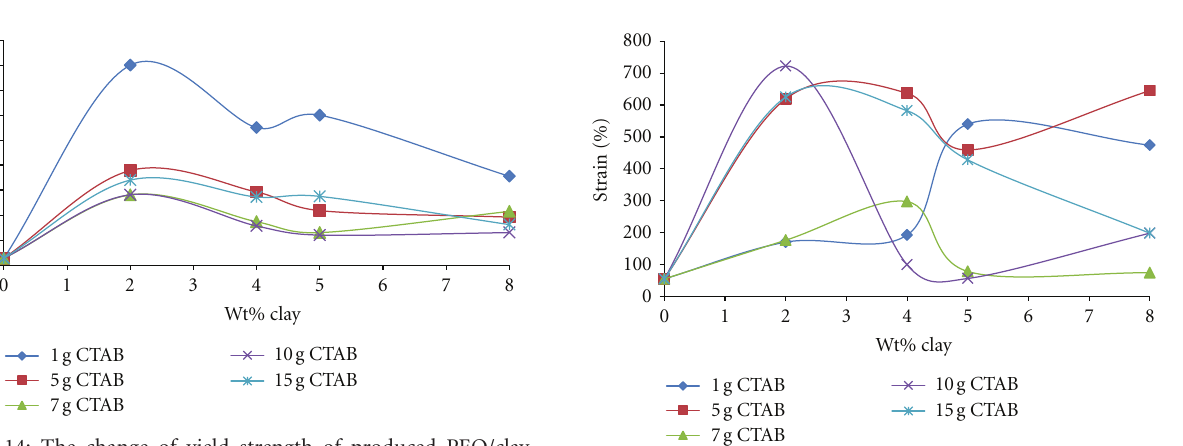
Figure 15: The change of values of strain percent of produced PEO/ clay nanocomposites at various CTAB/clay ratios with